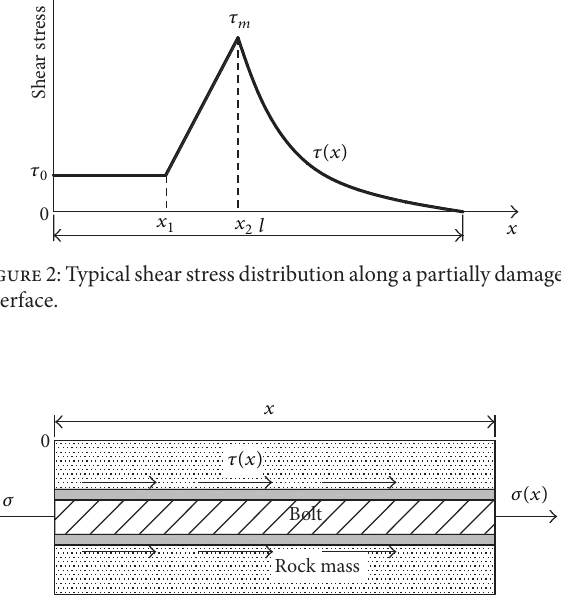
Figure 3: Micromechanical model of an anchoring